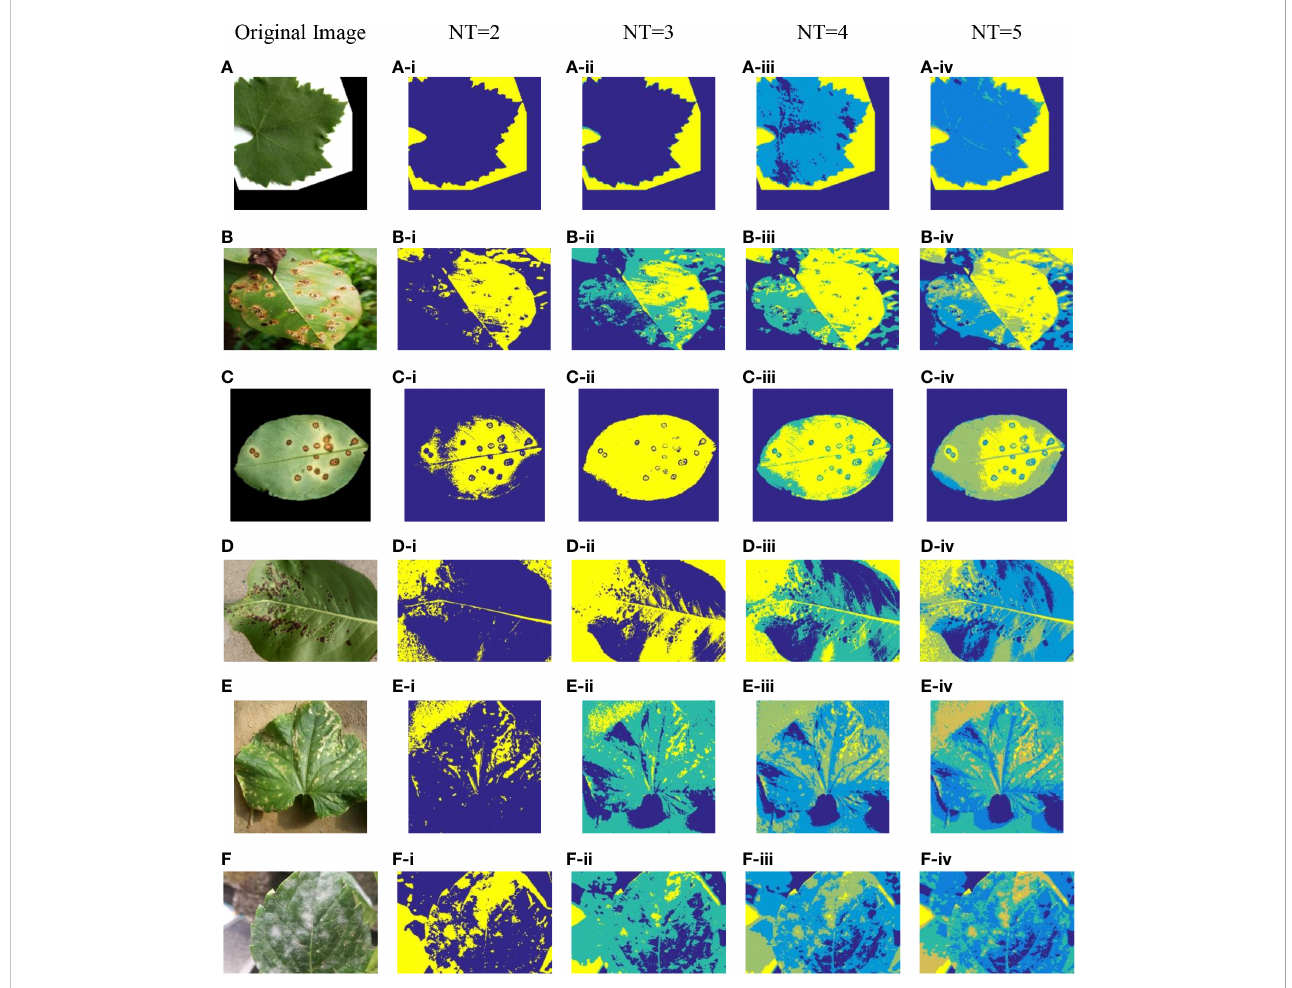
FIGURE 2 Plant image segmentation based on CAPSA. (A) Leaf01. (B) Apple Brown Spot. (C) Citrus Bacterial Canker. (D) Black Spot. (E) Bacterial Keratosis of Cucumber. (F) Powdery